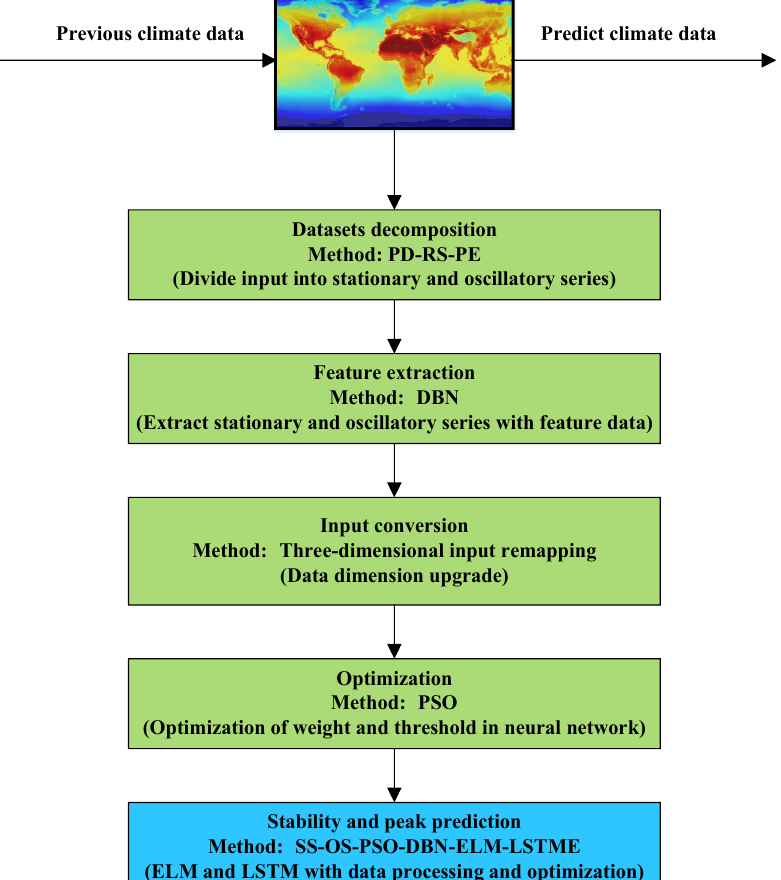
Figure 1. Overall flow chart of this paper.